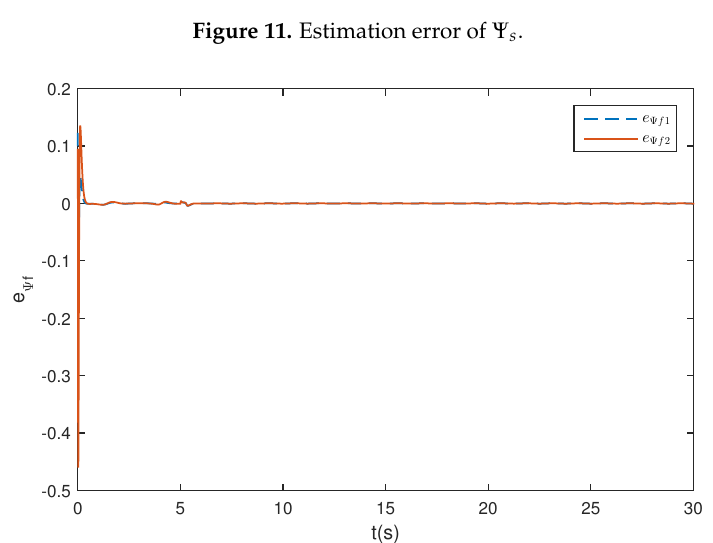
Figure 11. Estimation error of Ψ s .